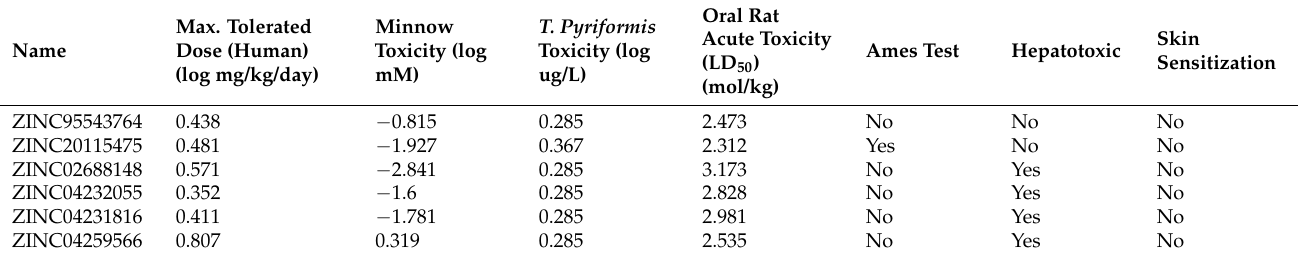
Table 5. Toxicity analysis of shortlisted compound against